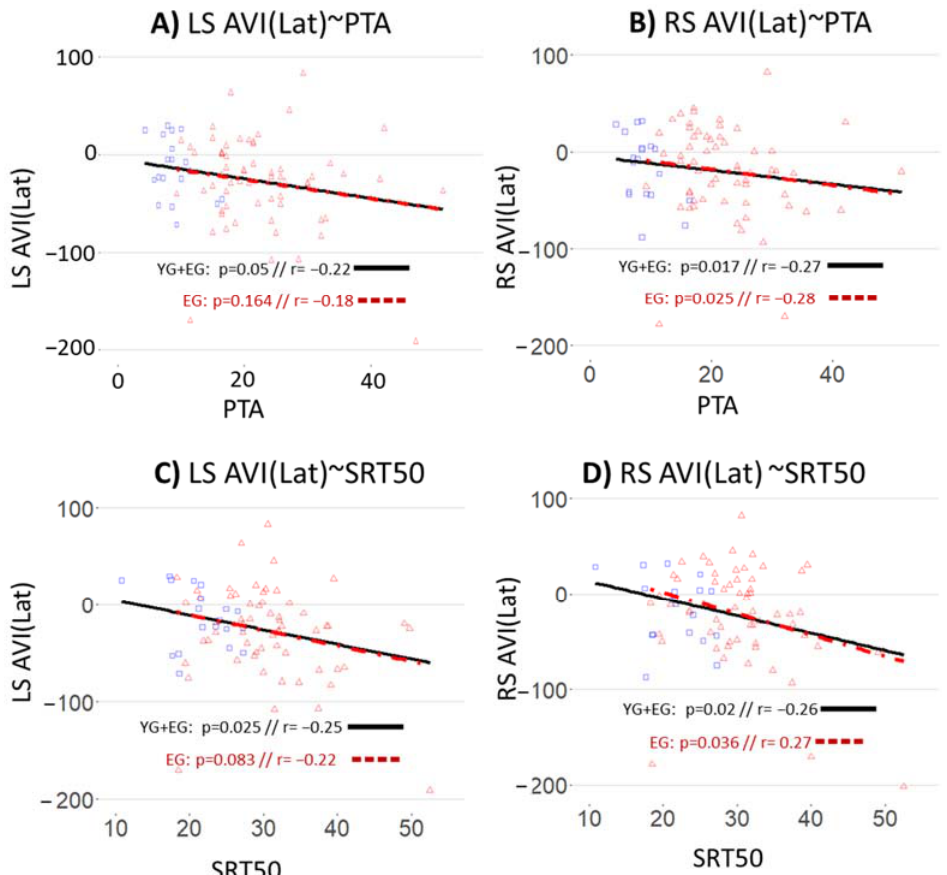
Figure 4. Correlations and regression lines between AVI(Lat) for saccades and hearing tests (PTA and SRT50), for the whole population (YG + EG) and for the elderly participants alone (EG). The left column ( A , C ) is for Left Saccade (LS); the right column ( B , D ) is for Right Saccade (RS); the first line is for the PTA; the second line is for SRT50. Blue squares represent the participants of the YG; red triangles represent the participants of the EG. The black solid line represents the regression line for the whole population (YG + EG) and the red dashed line represents the regression line for the elderly participants alone (EG). “r” represents the Pearson correlation coefficient and “ p ” represents the significance of the slope of the regression line.